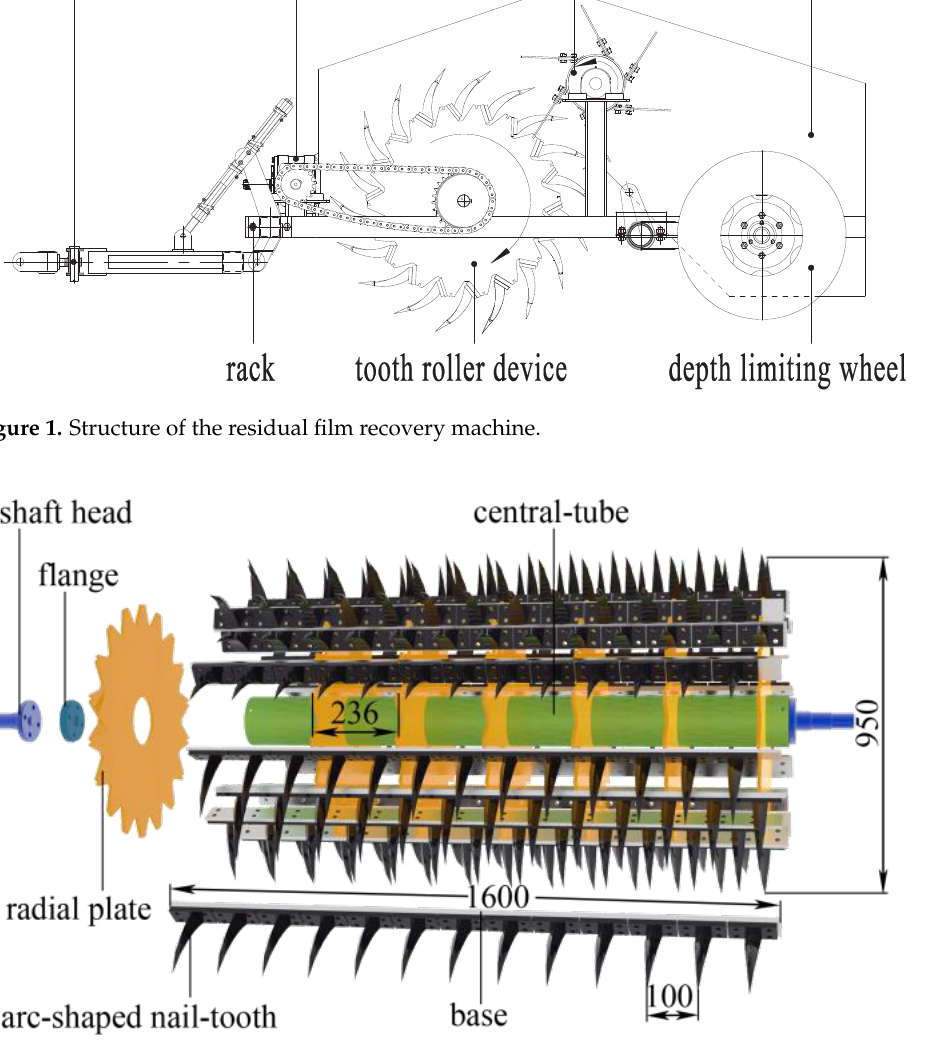
Figure 2. Structure diagram of the tooth roller device.